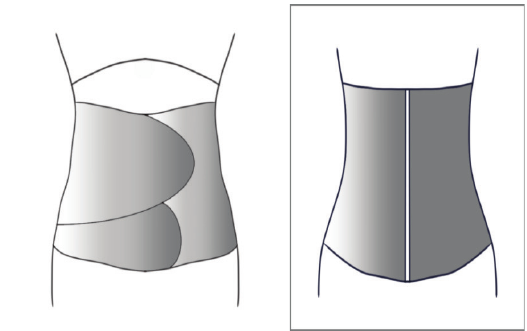
Figure II-III: Different types of Belly Wraps (Velcro) left and (Zipped)